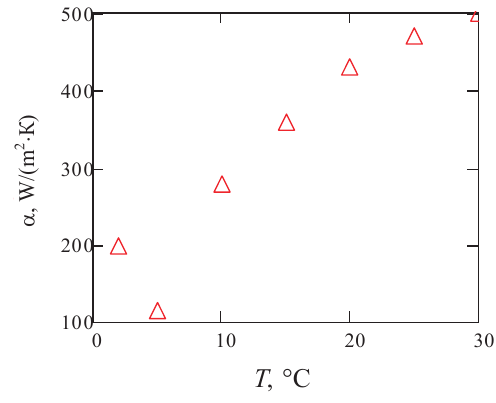
Figure 3 Heat-transfer coefficient as a function of the temperature of water for the